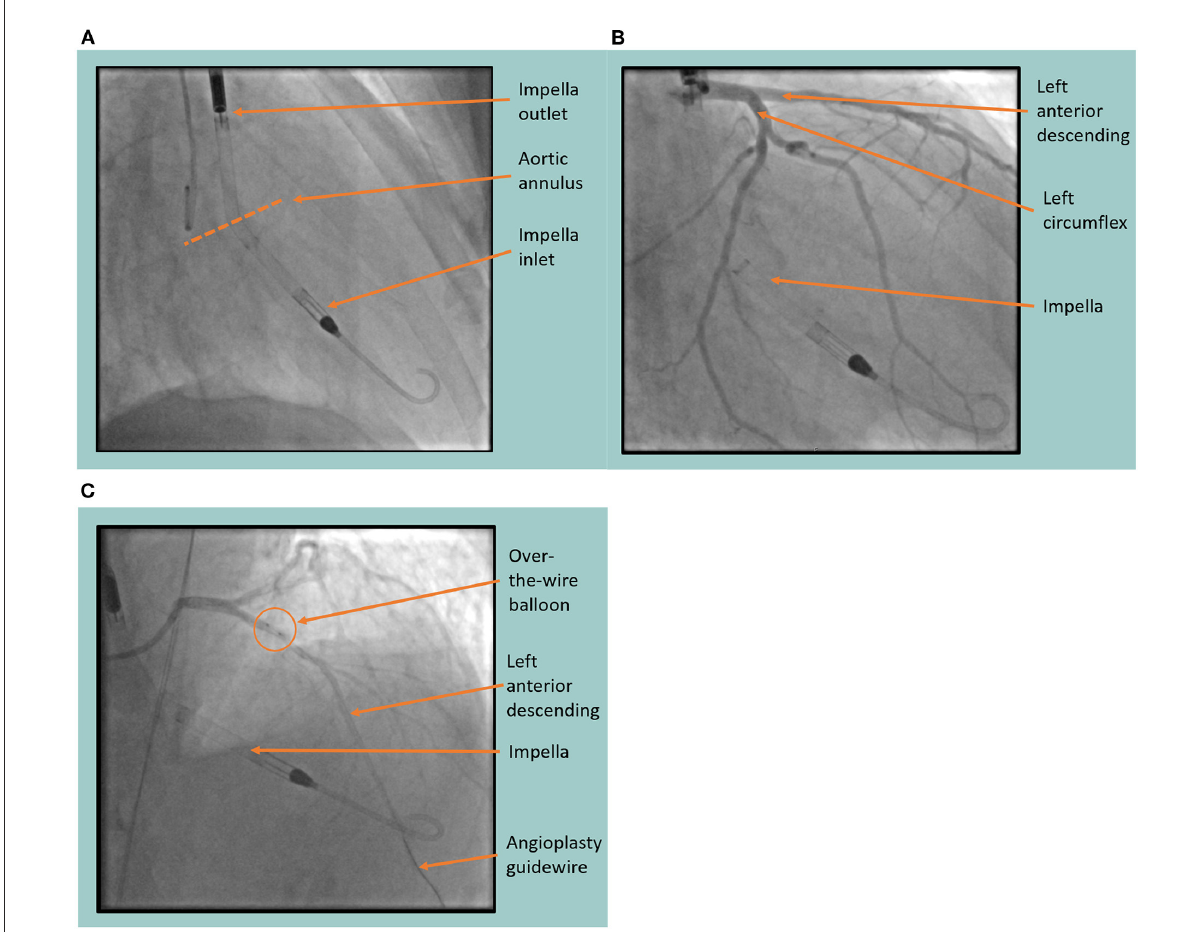
FIGURE3 Fluoroscopic images of the Impella (Abiomed, Danvers, MA) assisted cell infusion procedure. (A) The Impella device is sited in the left ventricle showing the inlet and outlet port either side of the aortic annulus. (B) Coronary angiography is performed, identifying the left anterior descending and left circumflex coronary arteries with the Impella in situ . (C) Coronary angiogram showing the cell infusion procedure in the left anterior descending artery. Arrows indicate the position of the over-the-wire balloon in the proximal left anterior descending artery through which the cells are infused after the guide wire is